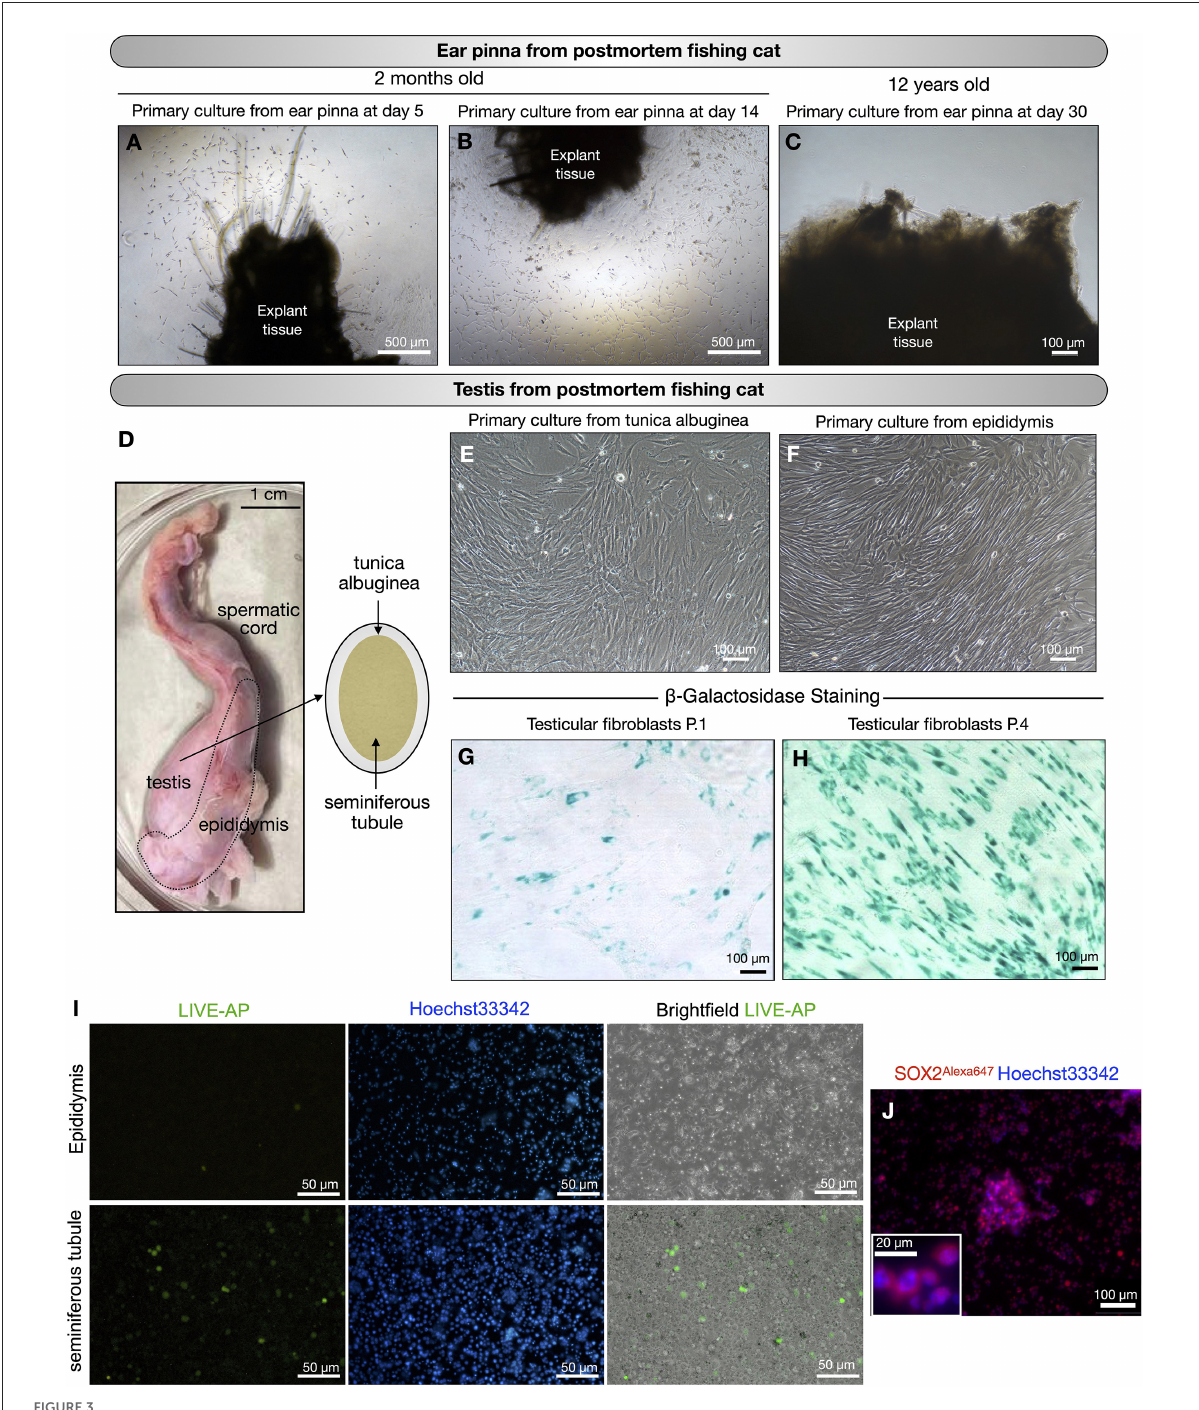
FIGURE3 Primary culture of postmortem fishing cats. (A–C) Primary culture of tissues collected from ear pinna of postmortem fishing cats. (A,B) young fishing cat at age 2 months. (C) Adult fishing cat at age 12 years. No cells expanded from ear pinna explant in primary culture at day 30. (D–J) Primary culture of tissues collected from testis of postmortem fishing cat (adult at age 12 years). (D) Male reproductive organ of fishing cat collected for primary culture. (E) Fibroblast outgrowth from tunica albuginea explants. (F) Fibroblast outgrowth from epididymis explants. (G,H) Fibroblasts from the testes at passage 1 and passage 4 were tested for cell senescence. (I) Live alkaline phosphatase (Live-AP) staining was used to detect the presence of putative spermatogonial stem cells (SSCs) from seminiferous tubules and epididymis. Green color indicates possible signal for AP activity. (J) Immunostaining of seminiferous tubule extract to detect SOX2 protein (Red, Alexa647) with nuclear staining Hoechst33342. Inset shows zoom-up of SOX2-positive